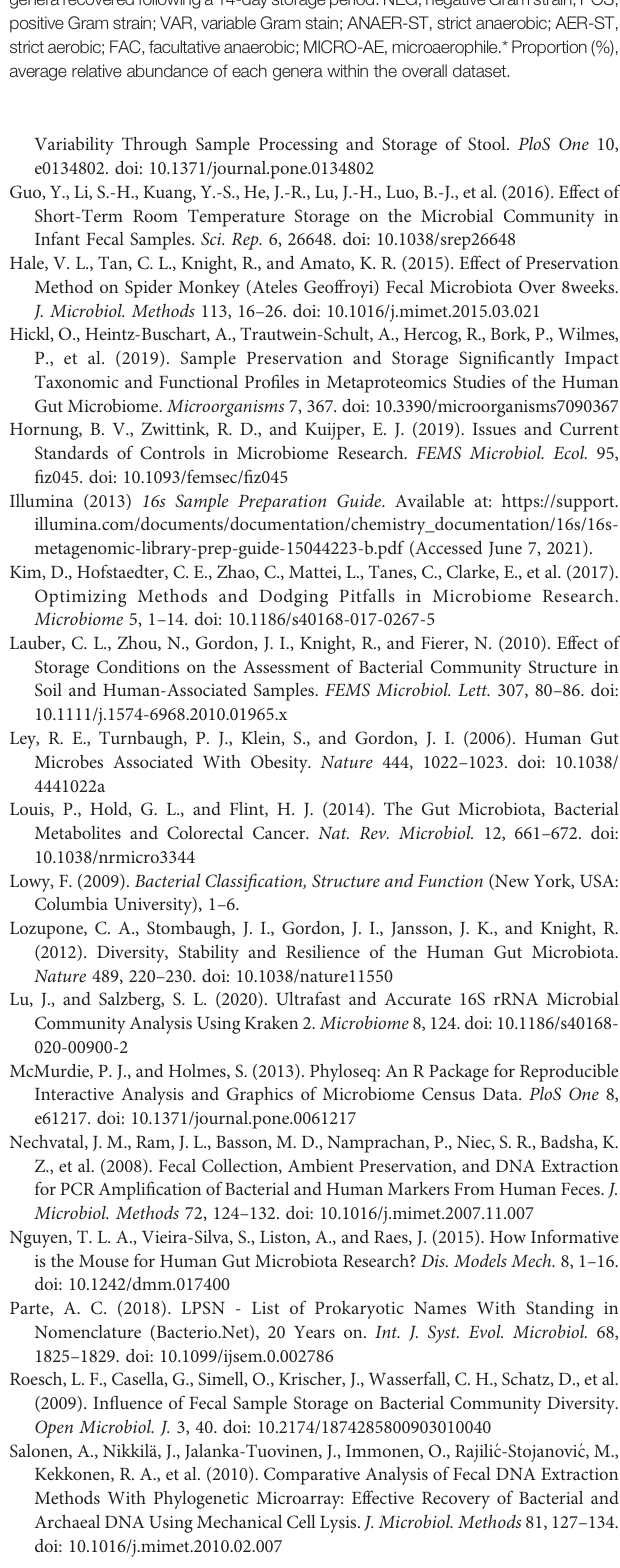
Supplementary Table 1 | Phenotypic characteristics of the 50 most abundant generarecoveredfollowinga14-daystorageperiod.NEG,negativeGramstrain;POS, positive Gram strain;VAR,variableGram stain;ANAER-ST, strict anaerobic; AER-ST, strictaerobic;FAC,facultativeanaerobic;MICRO-AE,microaerophile.*Proportion(%), average relative abundance of each genera within the overall